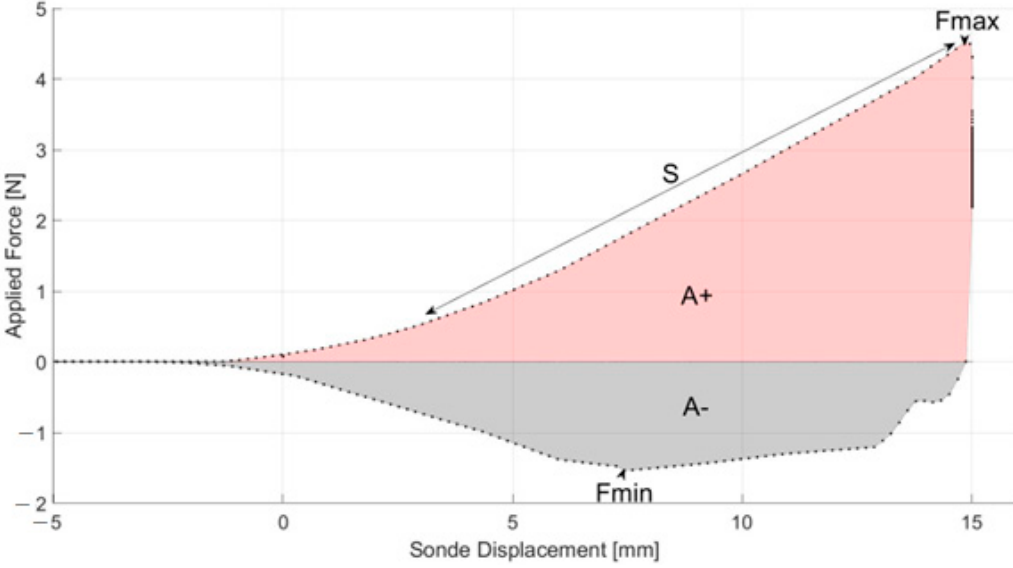
Figure 4. Experimental penetration curve for hydroxide sludge.